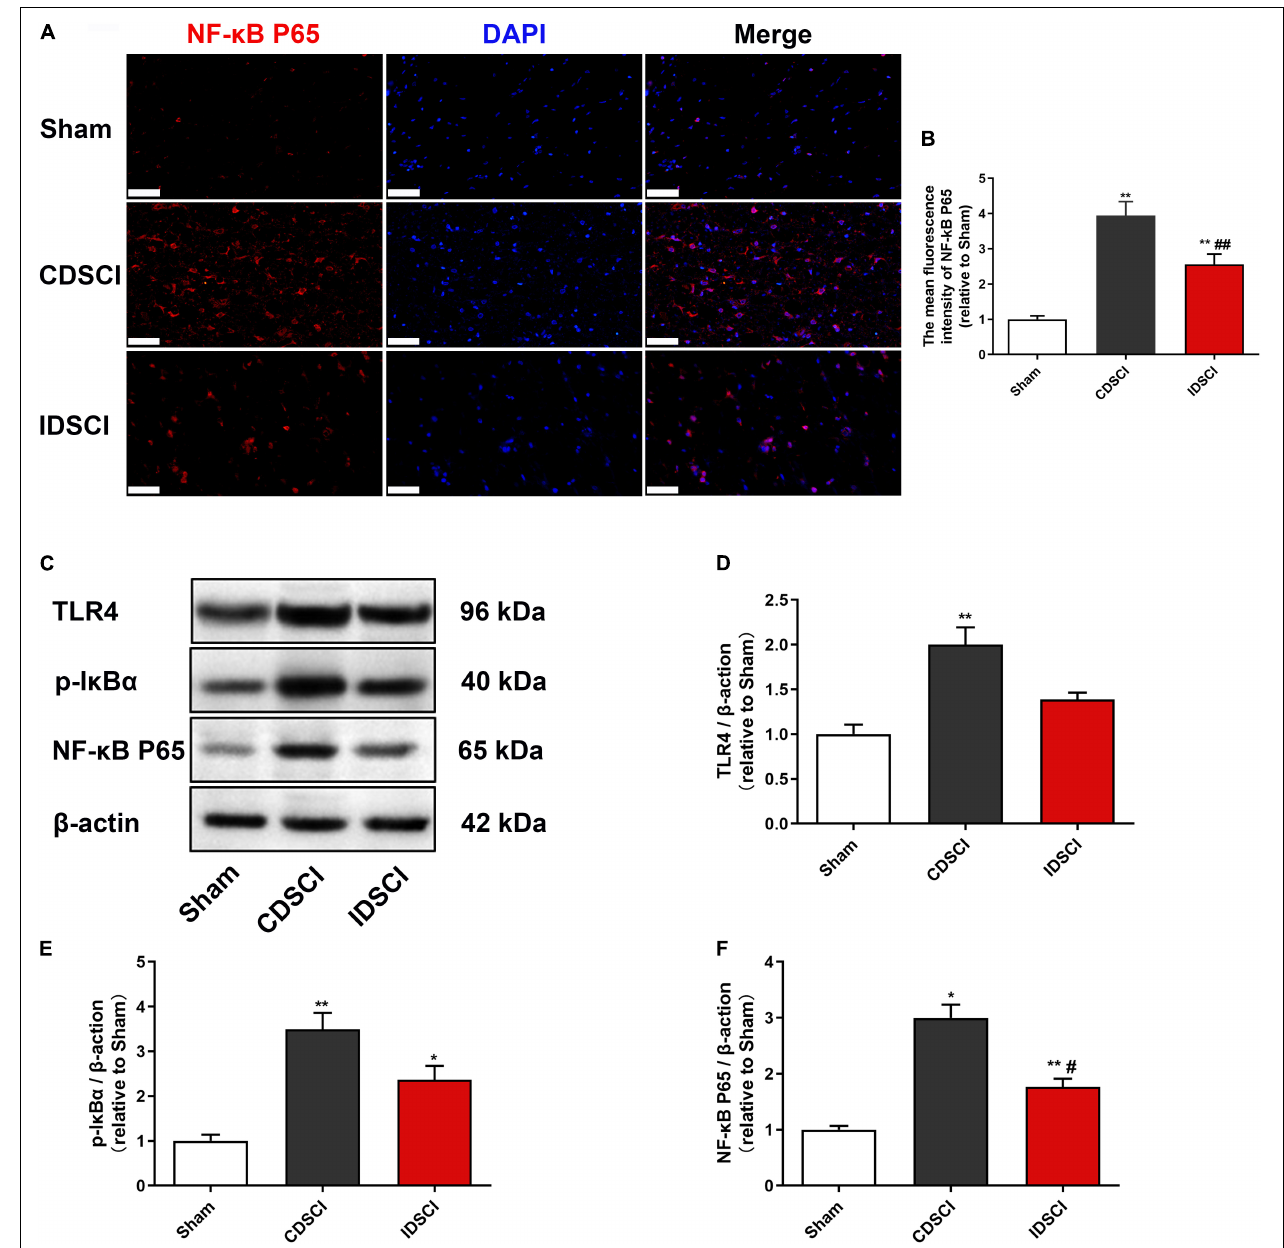
FIGURE 6 | Determination of the expression levels of TLR4/NF- κ B signaling pathway-related proteins in the spinal cord tissues after DSCI. (A) Representative immunostaining images of NF- κ B P65 (red) and DAPI (blue) in the spinal cord tissues at day 7 post-surgery (scale bar = 50 µ m). (B) The mean fluorescence density of NF- κ B P65 quantification in the aim field was measured ( n = 3). (C) The representative immunoblots of TLR4, p-I κ B α , NF- κ B P65, and β -actin are listed. (D–F) Grayscale values of TLR4, p-I κ B α , and NF- κ B P65 were determined using ImageJ software based on the bands in the immunoblots ( n = 3). All values are expressed as means ± SD. * P < 0.05, ** P < 0.01, vs. the sham group; # P < 0.05, ## P < 0.01, vs. the CDSCI